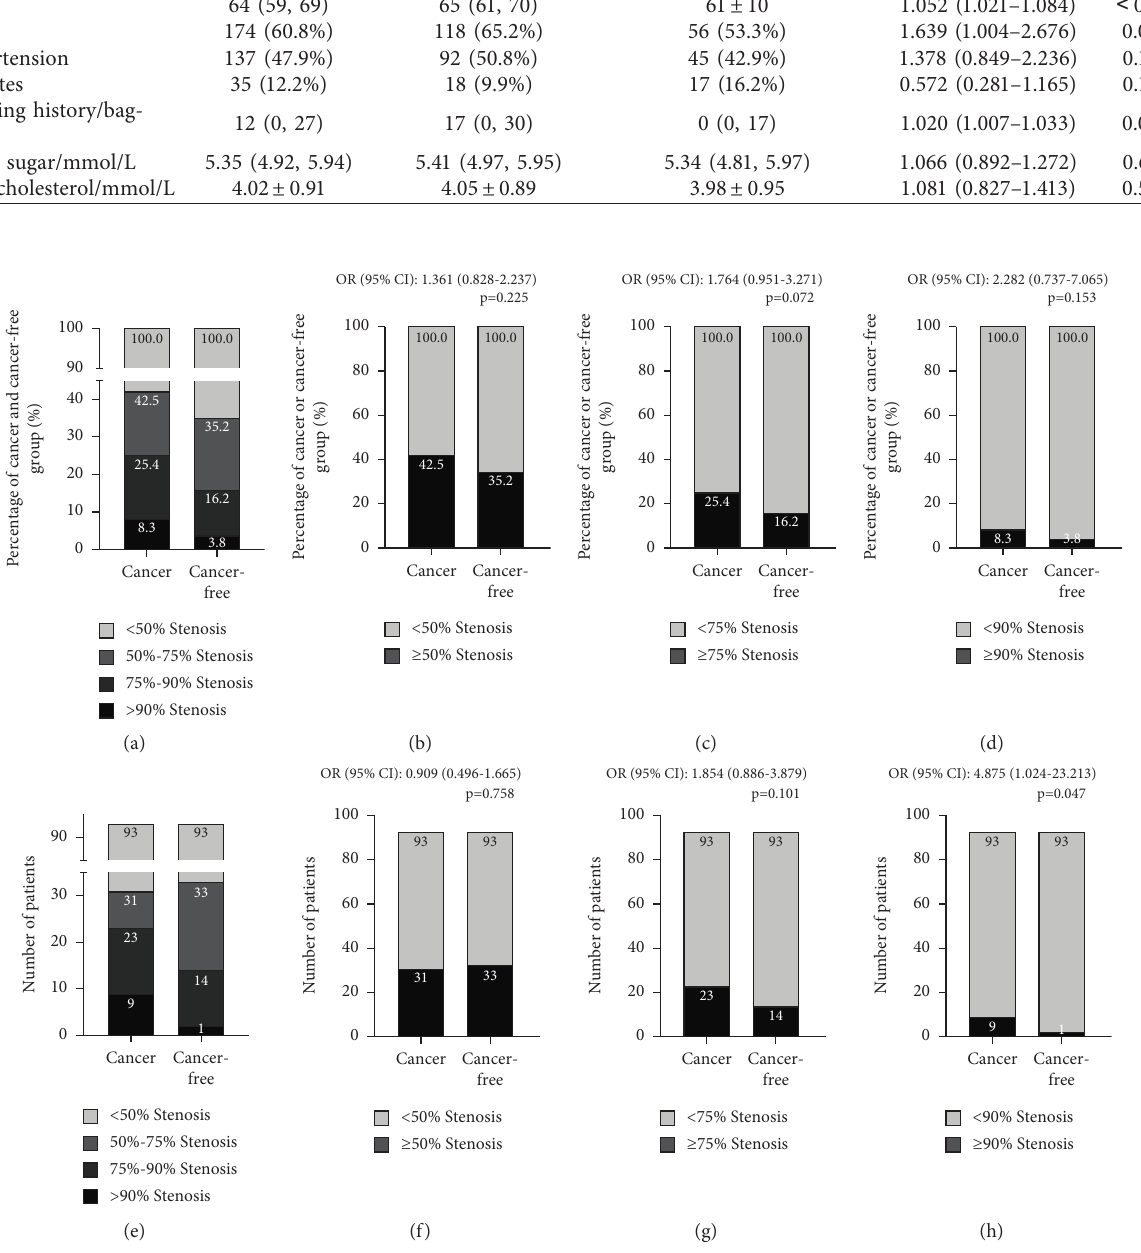
Figure 2: Severity of CAA in cancer and no-cancer patients. (a–d) Comparison of severity of CAA between cancer and no-cancer patients. (a) Cancer patients were more likely to have worse CAA compared with the cancer-free controls. (b), (c), (d) Cancer patients were slightly more likely to have ≥ 50%, ≥ 75%, and ≥ 90% coronary stenosis compared with the cancer-free controls. (e–h) Comparison of severity of CAA between gender- and age-matched cancer and no-cancer group. (h) Patients in the cancer group were significantly more commonly complicated by ≥ 90% coronary stenosis than patients in the no-cancer group (9/93 versus 1/93, OR � 4.875, 95% CI: 1.024–23.213, p � 0 .